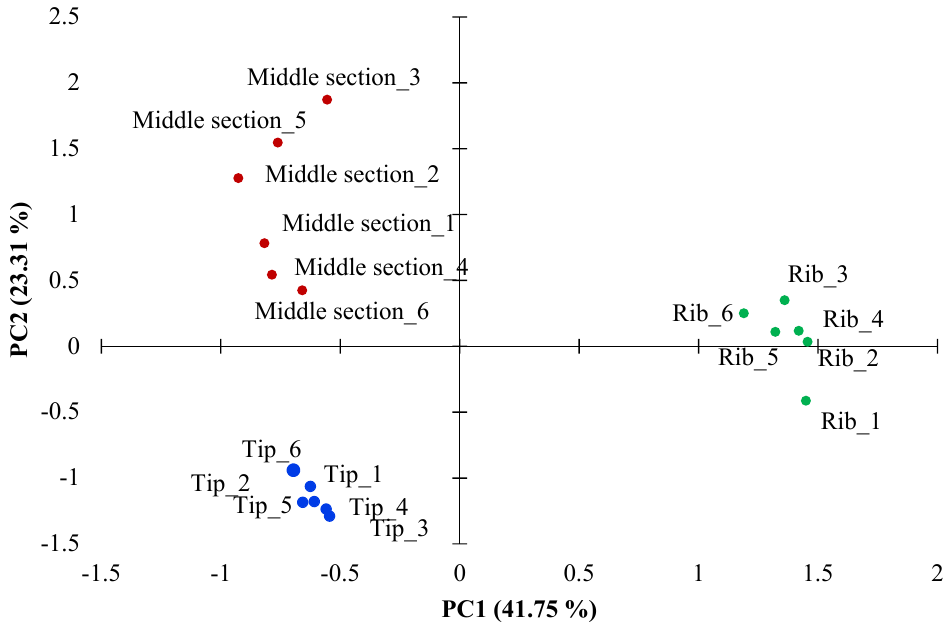
Figure 1. Projection of the antler samples of Iberian red deer ( Cervus elaphus ) of the three locations (tip, middle and rib) in the plane defined by the first two principal components.